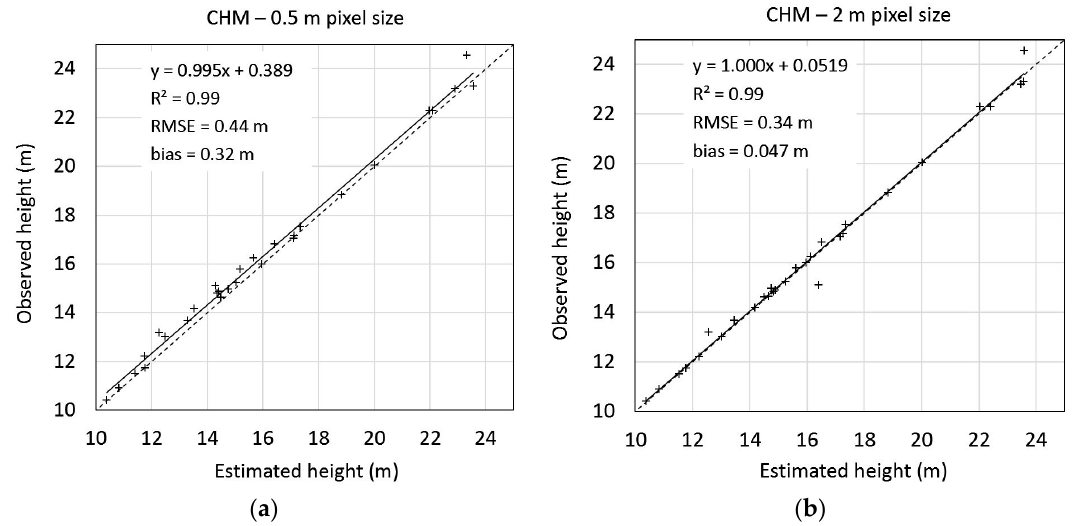
Figure 11. Estimated vs. observed measured tree height for two different resolutions of the canopy height model: ( a ) 0.5 m; ( b ) 2.0 m.